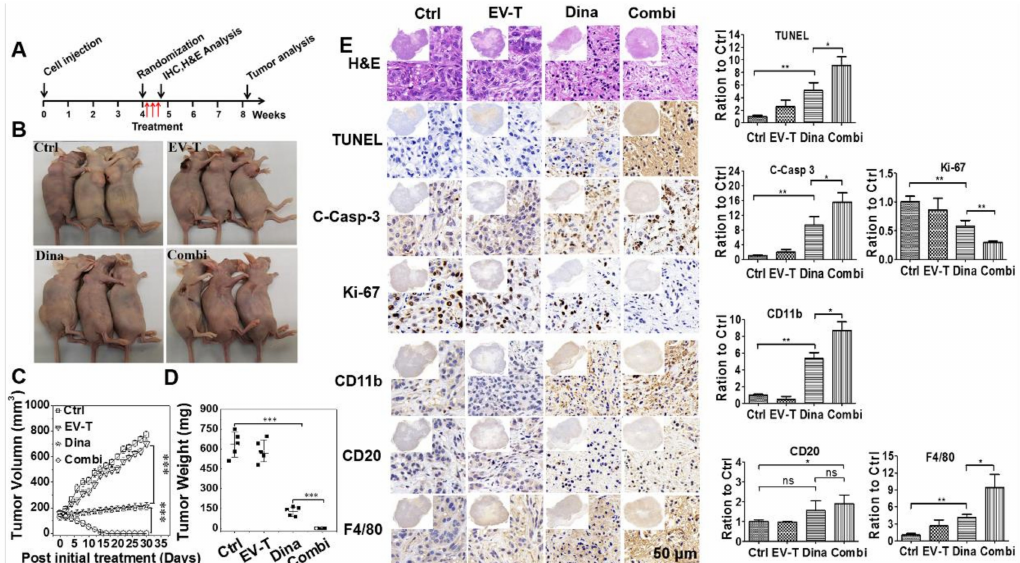
Figure 7. EV-T and dinaciclib combination therapy eradicates established subcutaneous lung tumors in vivo. ( A ) Experimental treatment schedule is shown. ( B ) Representative images of experimental mice at day 10 post last treatment. Each treatment comprises of intratumoral injection per animal of saline vehicle (Ctrl), 4.5 ng EV-T (corresponding to 50 µ g EVs) (EV-T), 160 µ g dinaciclib (Dina), or combination of 4.5 ng EV-T and 160 µ g dinaciclib (Combi), total three injections performed with a 48 h interval for each animal. ( C ) Tumor growth / volume curves after various treatment. ( D ) Statistical comparison of tumor weight for various therapies at the end of the experiment. ( E ) H&E and immunohistochemistry (IHC) analyses of subcutaneous A549 tumors harvested 12 h post the final treatment. Cell proliferation marker Ki-67, apoptosis (activated caspase 3 short for C-Casp-3, TUNEL) as well as tumor infiltrating of murine immune cells including natural killer (NK) (biomarker CD11b), B lymphocytes (CD20) and macrophages (F4 / 80) were examined. Quantification histogram of IHC positive staining signal intensity for each marker molecule is shown with saline control value set as 1. Ten di ff erent but histologically similar fields were selected for quantification for each sample and the slides were analyzed quantitatively using Image-pro plus 6.0 software. All values are mean ± S.E.M ( n = 3), ns, not significant, * p < 0.05, ** p < 0.01, *** p < 0.001, Students’ T